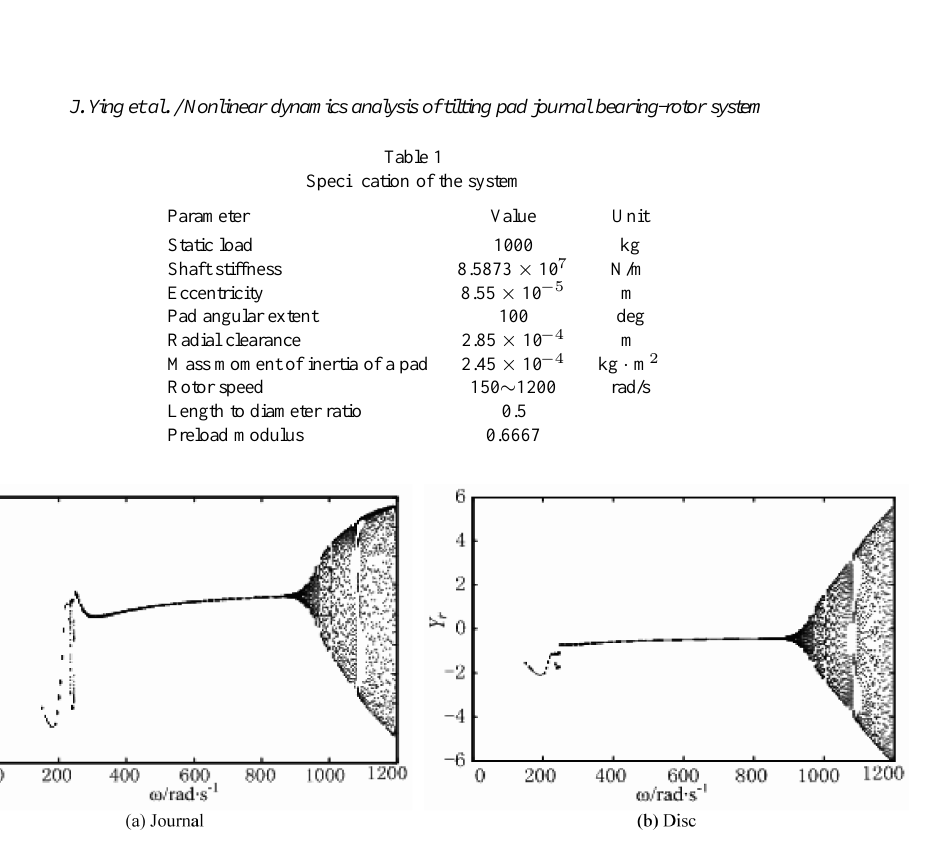
Fig. 3. Bifurcation diagrams of the shaft and the disc (with the pad’s moment of